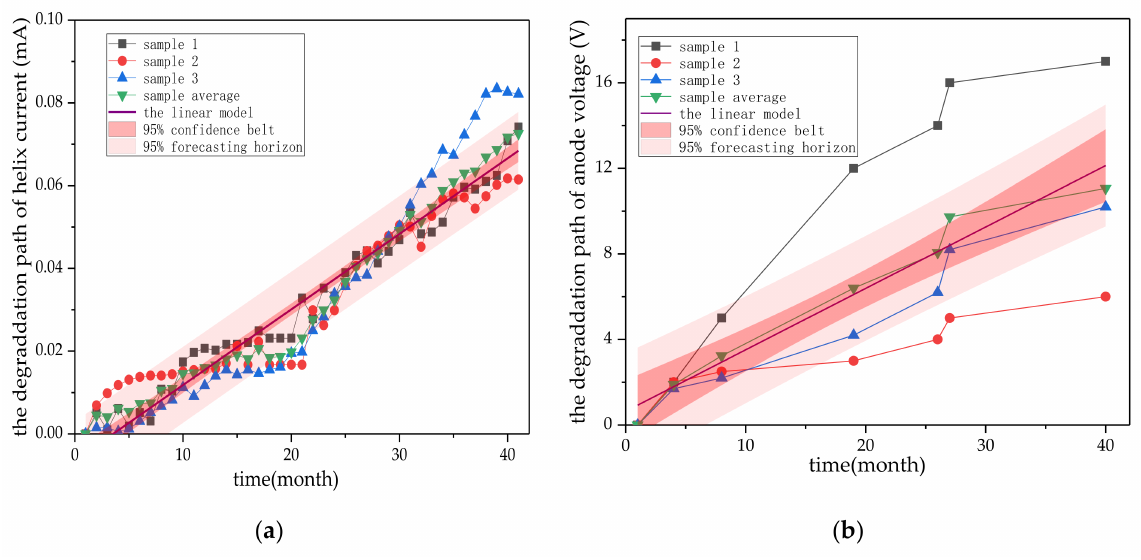
Figure 3. The degradation trajectory of TWTA. ( a ) Helix current degradation path and ( b ) anode voltage degradation